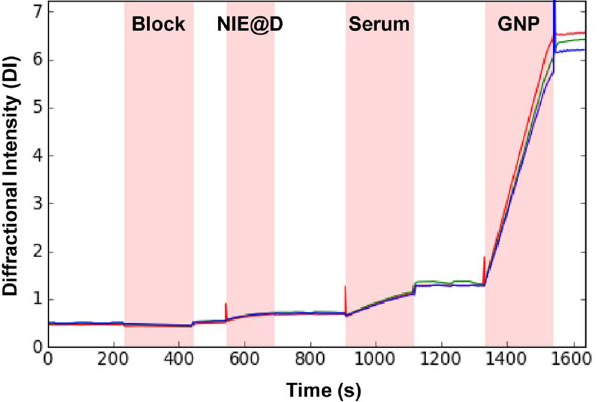
Figure 3. Representative trace of a dot-based serological analysis of a Strongyloides positive serum sample. The dotLab mX System outputs a real time trace displaying each reagent incubation and wash step in the assay. Note the binding curves representing the immobilization of NIE@D conjugate and serum anti-NIE antibodies. Significant signal amplification is achieved using anti-human IgG antibody conjugated gold nanoparticles (GNP). The three superimposed traces represent the results of a single assay performed with three spot monitoring.